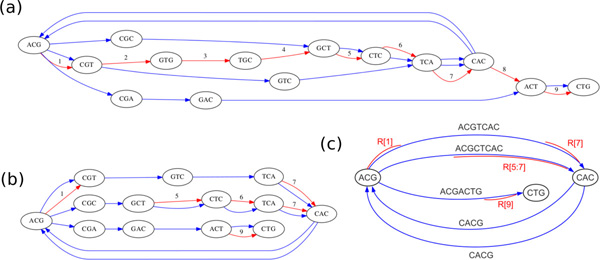
Construction of a condensed reference/donor graph in a more complex case. In the first pass, any reference edges with no parallel donor edge are removed. In the second pass, linear subpaths are condensed to single edges, and the parallel reference edges are summarized using reference markers. (a) Initial reference/donor graph. (b) Intermediate graph with isolated reference edges removed. (c) Final condensed reference/donor graph, with reference markers shown.